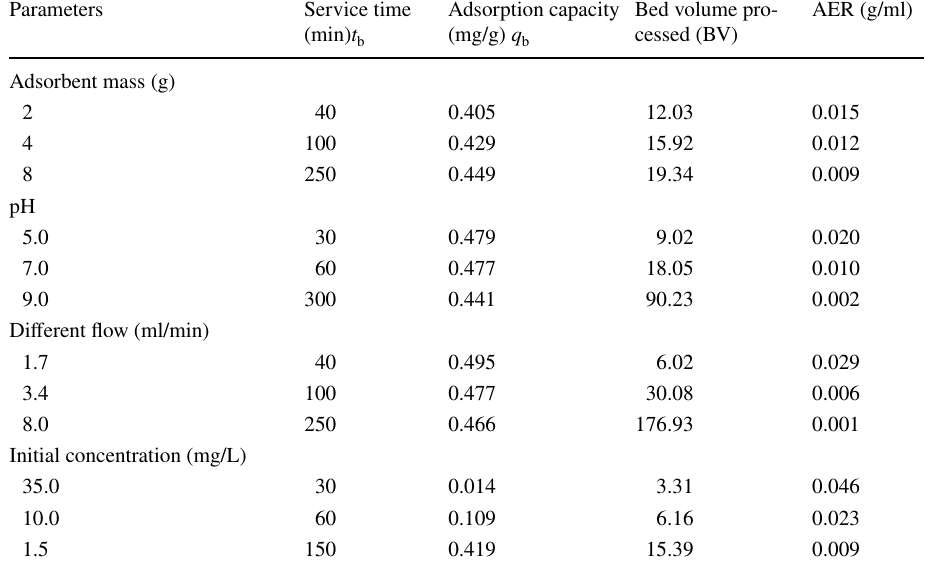
Table 2 Summary of pertinent results at breakthrough point of banana